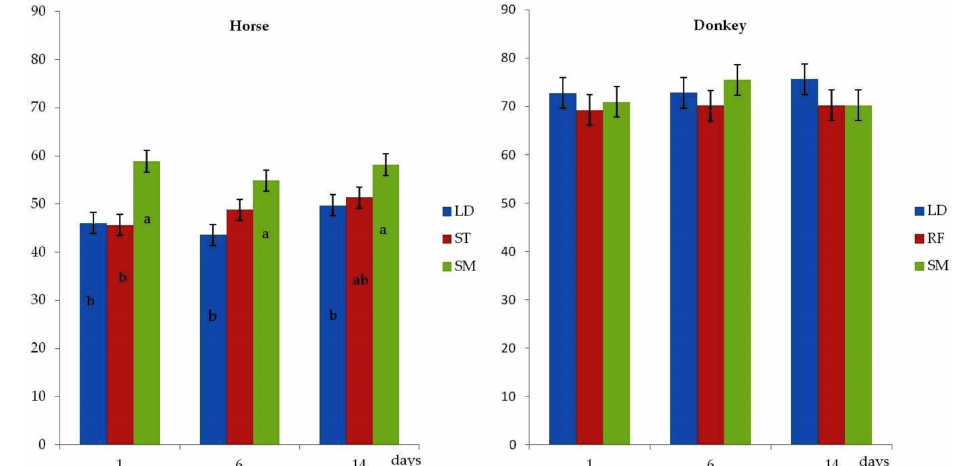
Figure 1. Effect of muscle and aging time (days) on cholesterol content (mg/100 g) of meat from horse and donkey (means ± SEM; LD = Longissimus Dorsi; SM = Semimembranosus; ST = Semitendinosus; RF = Rectus Femoris). a, b = p < 0.05 (muscle